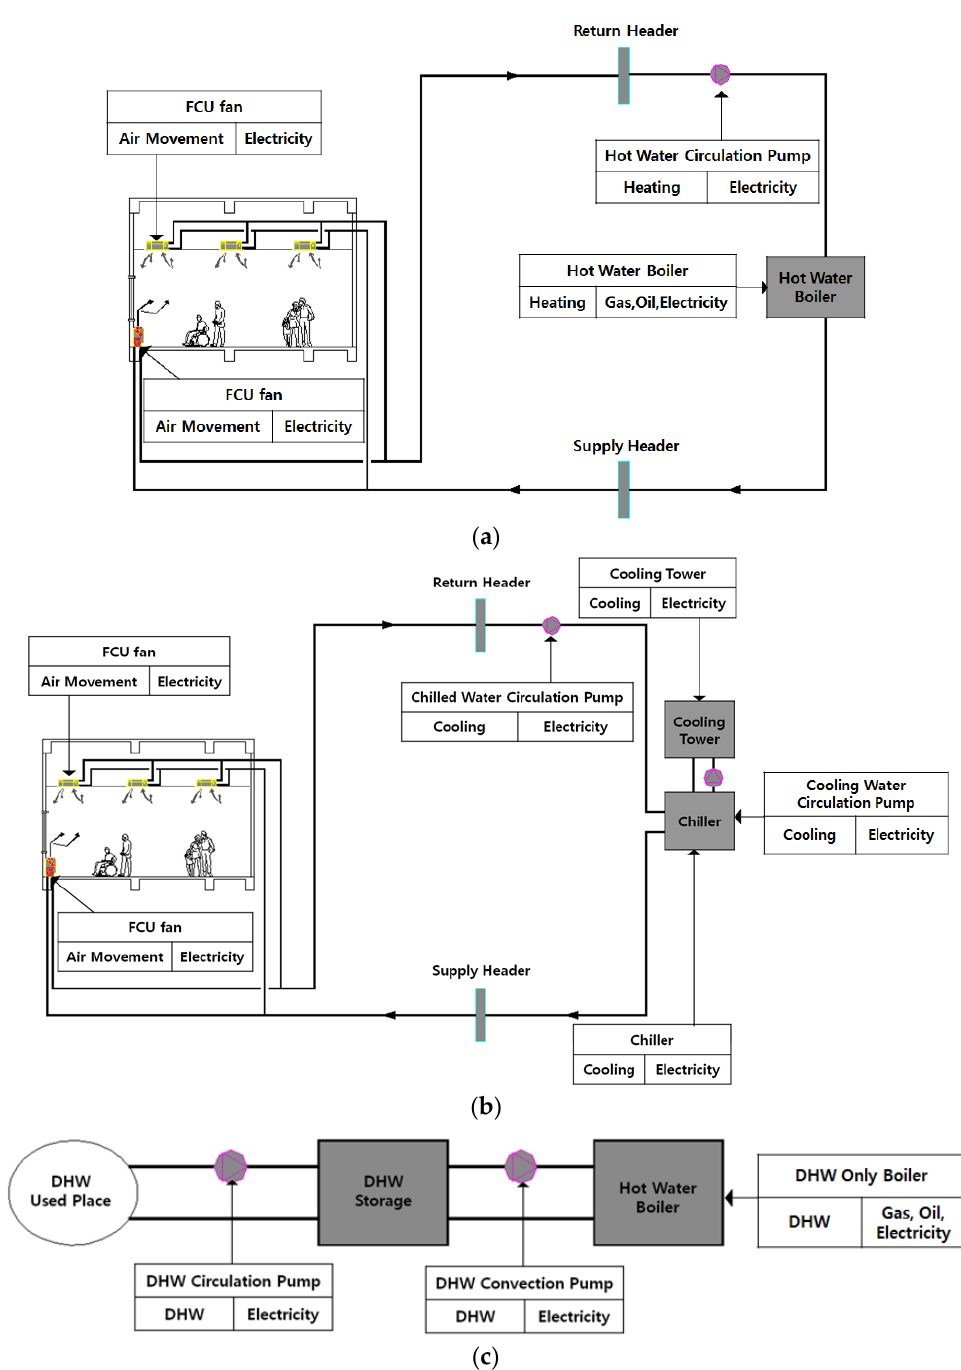
Figure A1. Illustrations of energy consumption measurements by end-use. ( a ) Heating energy Figure C1. Illustrations of energy consumption measurements by end-use. (a) Heating energy consumption of hot water boiler + fan coil unit (FCU); ( b ) Cooling energy consumption of compression consumption of hot water boiler + fan coil unit (FCU); (b) Cooling energy consumption of chiller + FCU; ( c ) Energy consumption of domestic hot water (DHW)-only central compression chiller + FCU; c) Energy consumption of domestic hot water (DHW)-only central boiler.